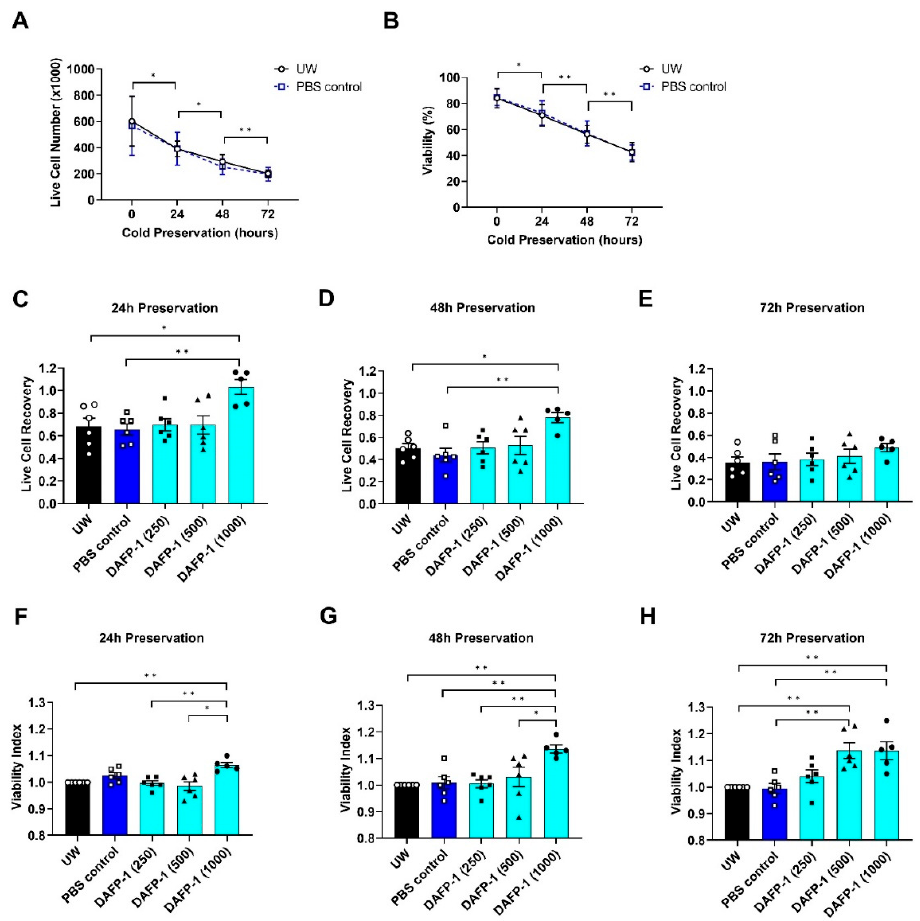
Figure 1. Survival of INS-1 cells cold preserved in UW solution supplemented with DAFP-1. INS-1 cells were cold preserved in UW solution alone, UW solution containing vehicle (PBS control), or with 250, 500, and 1000 µ g/mL DAFP-1 for up to 72 h. ( A ) The live cell number and ( B ) the viability of INS-1 cells before and after the cold preservation in the UW solution or PBS control group tested at 24, 48, and 72 h of preservation. The data show the mean ± standard deviation of six independent experiments, * p < 0.05, ** p < 0.01, by the one-way ANOVA. The live cell number of INS-1 cells after ( C ) 24 h, ( D ) 48 h, and ( E ) 72 h of cold preservation was compared to pre-preservation shown by the live cell recovery (live cell number at each time point divided by the live cell number before preservation), and the INS-1 cell viability of each protein group was compared to the UW solution group at ( F ) 24 h, ( G ) 48 h, and ( H ) 72 h shown as viability index (viability of INS-1 cells preserved in each condition divided by the viability of INS-1 cells preserved in the UW solution). The data show the mean ± standard error of five to six independent experiments (open circle for UW alone, open square for PBS control, solid square, solid triangle, and solid circle for 250, 500 and 1000 µ g/mL DAFP-1, respectively), * p < 0.05 and ** p < 0.01 by the one-way